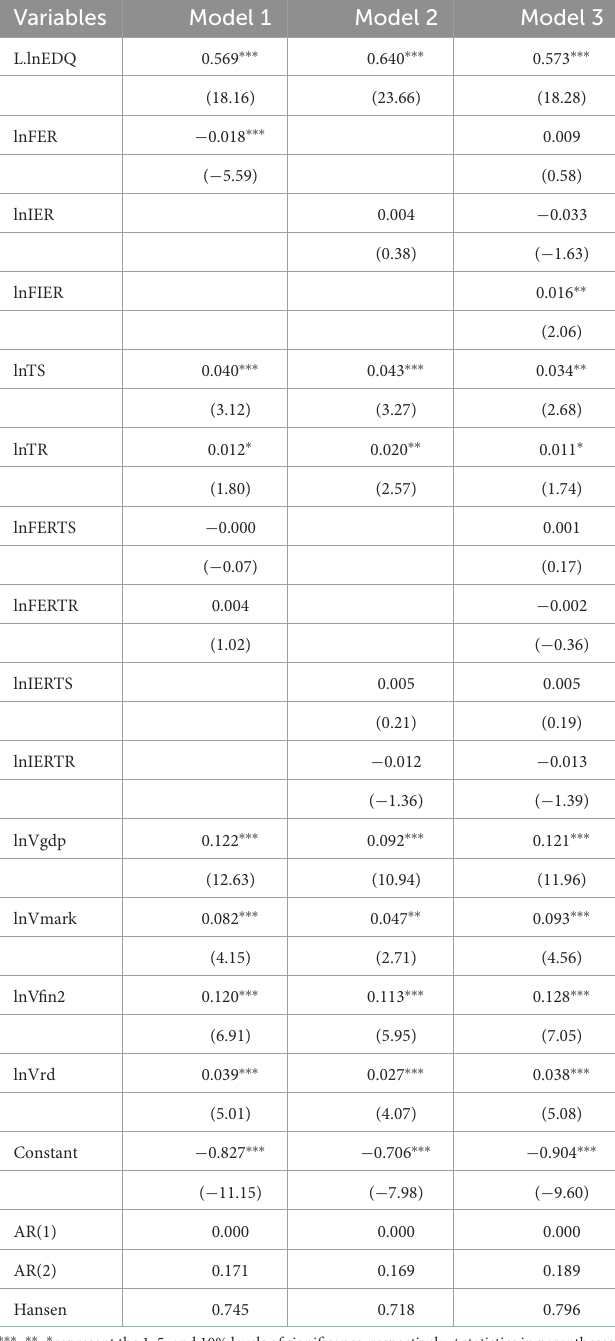
TABLE 9 Endogeneity